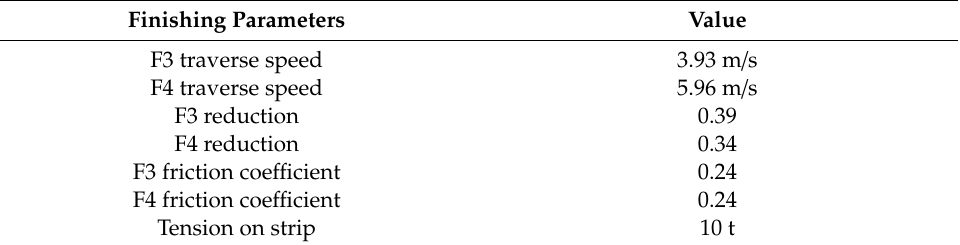
Table 2. Finishing parameters of F3 and F4.